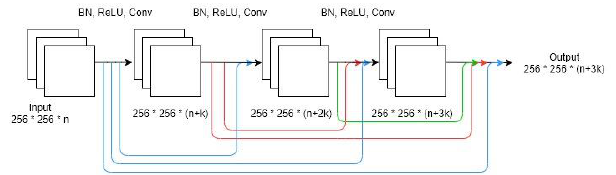
Figure 2. A 3-layer dense block with n input channels and k growth rate. Please refer to texts for the abbreviations .